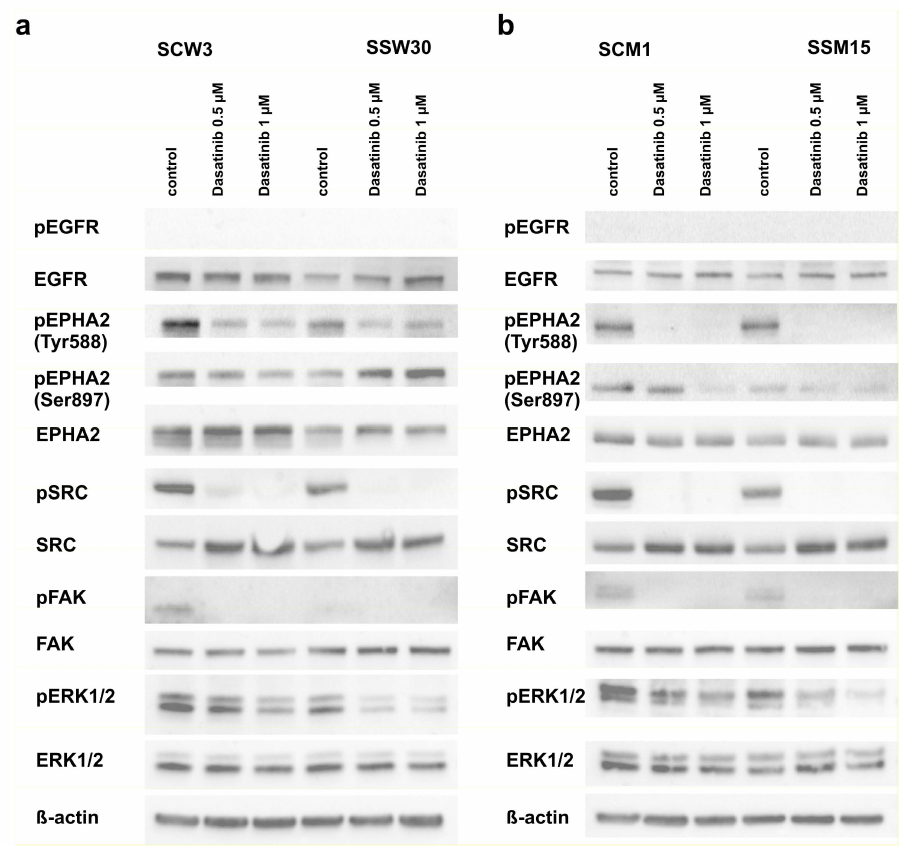
Figure 6. SIRT2 downregulation impairs the expression and phosphorylation of tyrosine kinase receptor-associated